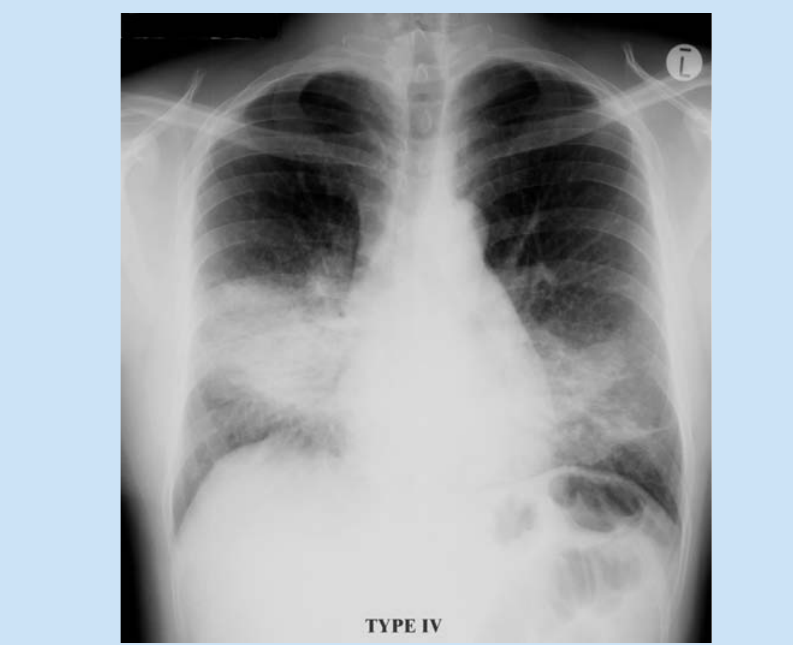
Fig. 5. Thirty-five-year-old male patient. Treated for bacterial infection for 1 month. Afebrile, persis- tent non-productive cough. Chest X-ray was done for follow-up of his